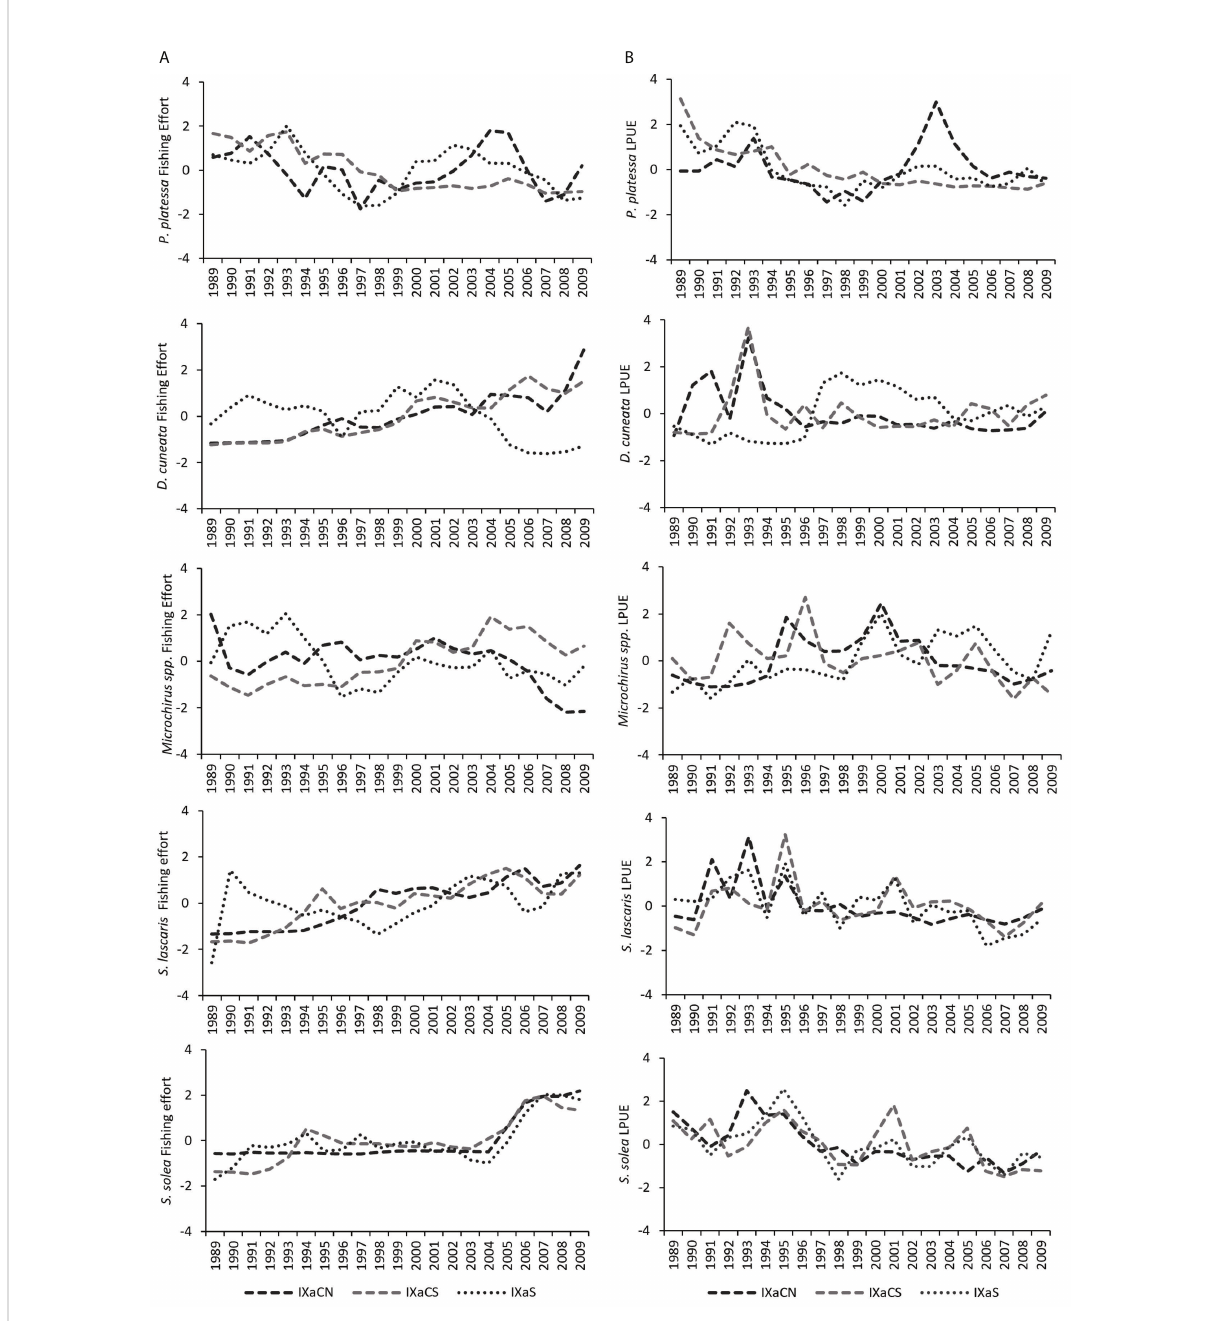
FIGURE 3 (A) Standardised yearly fi shing effort (number of fi shing days by boat, and (B) Landings per unit effort (LPUE: kg per fi shing days by boat) for Pleuronectes platessa , Dicologlossa cuneata , Microchirus spp., Solea lascaris , and Solea solea between 1989 and 2009 in Northwestern (IXaCN), Southwestern (IXaCS) and Southern (IXaS) coasts of